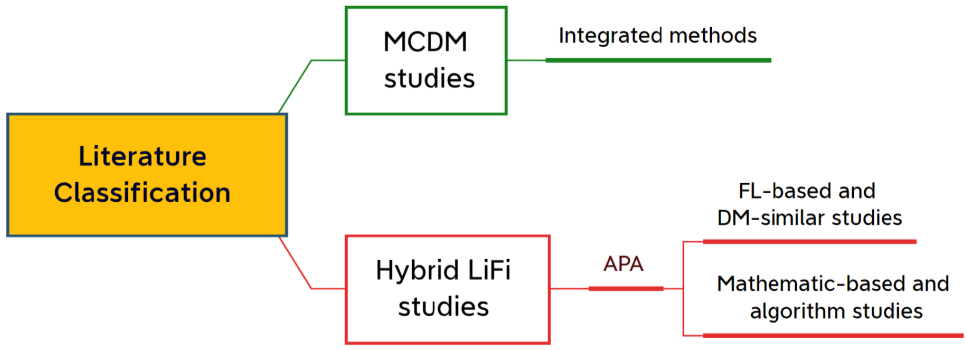
Figure 2. Literature review classification.